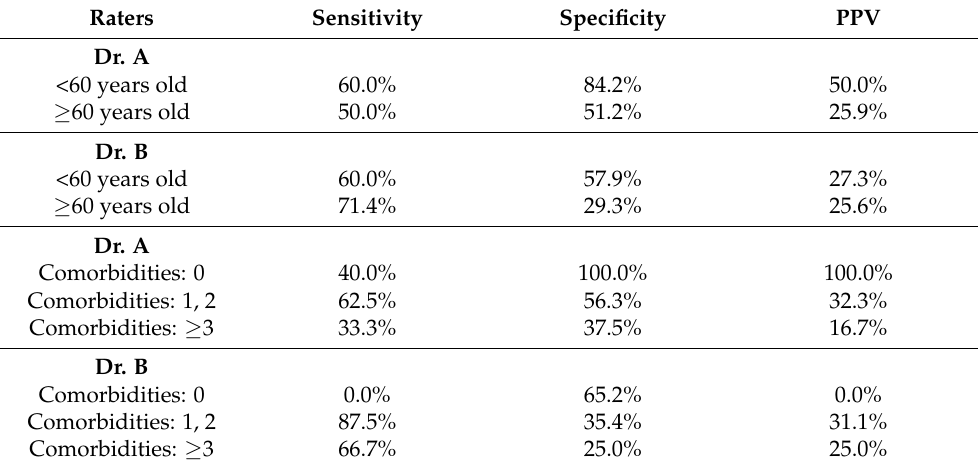
Table 7. Validity analysis of oculomotor tests according to age and comorbidities in both